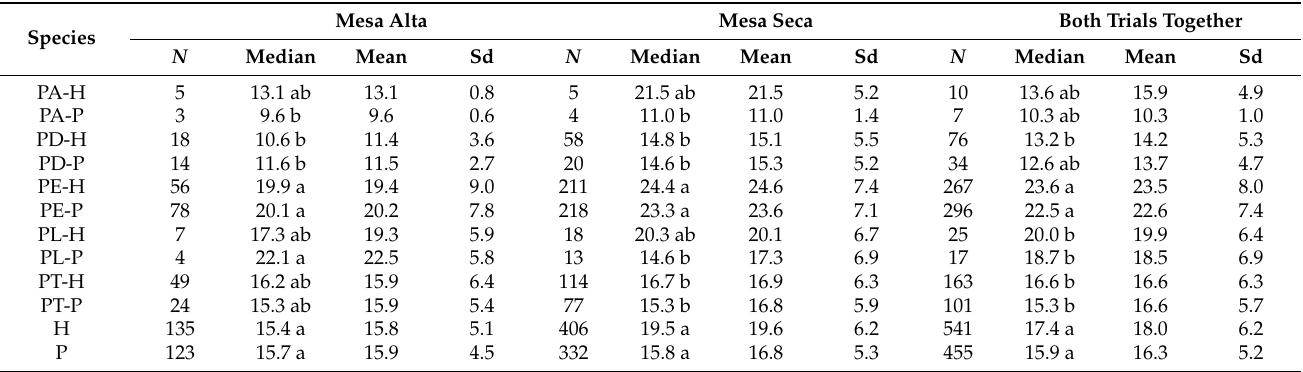
Table 2. Descriptive statistics of the basal diameter (mm) of the surviving seedlings of the five pure Pinus species and their hybrids, in each separate trial and both trials together, after 27 months in the field.